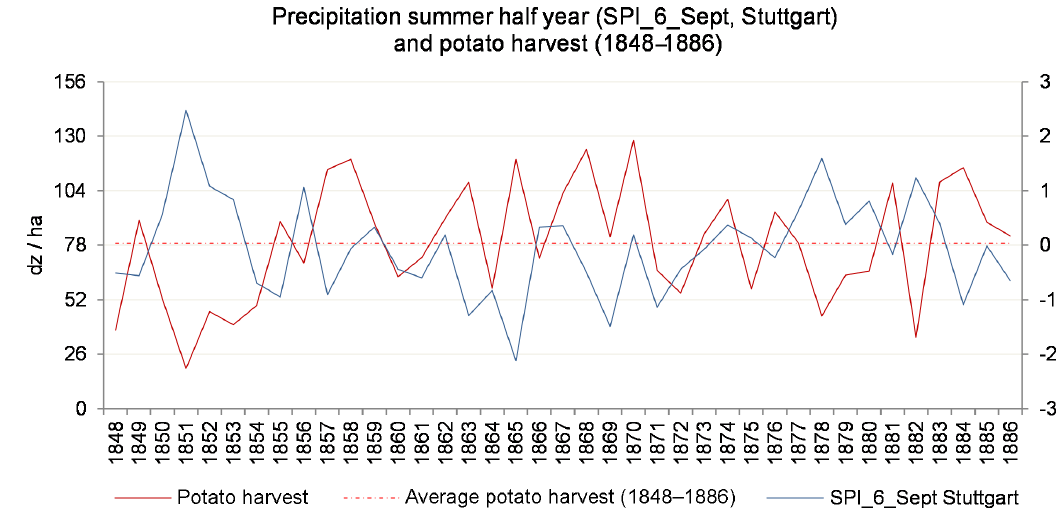
Figure 10. Potato harvest in Württemberg and the precipitation index for April–September (Stuttgart, 1848–1886).